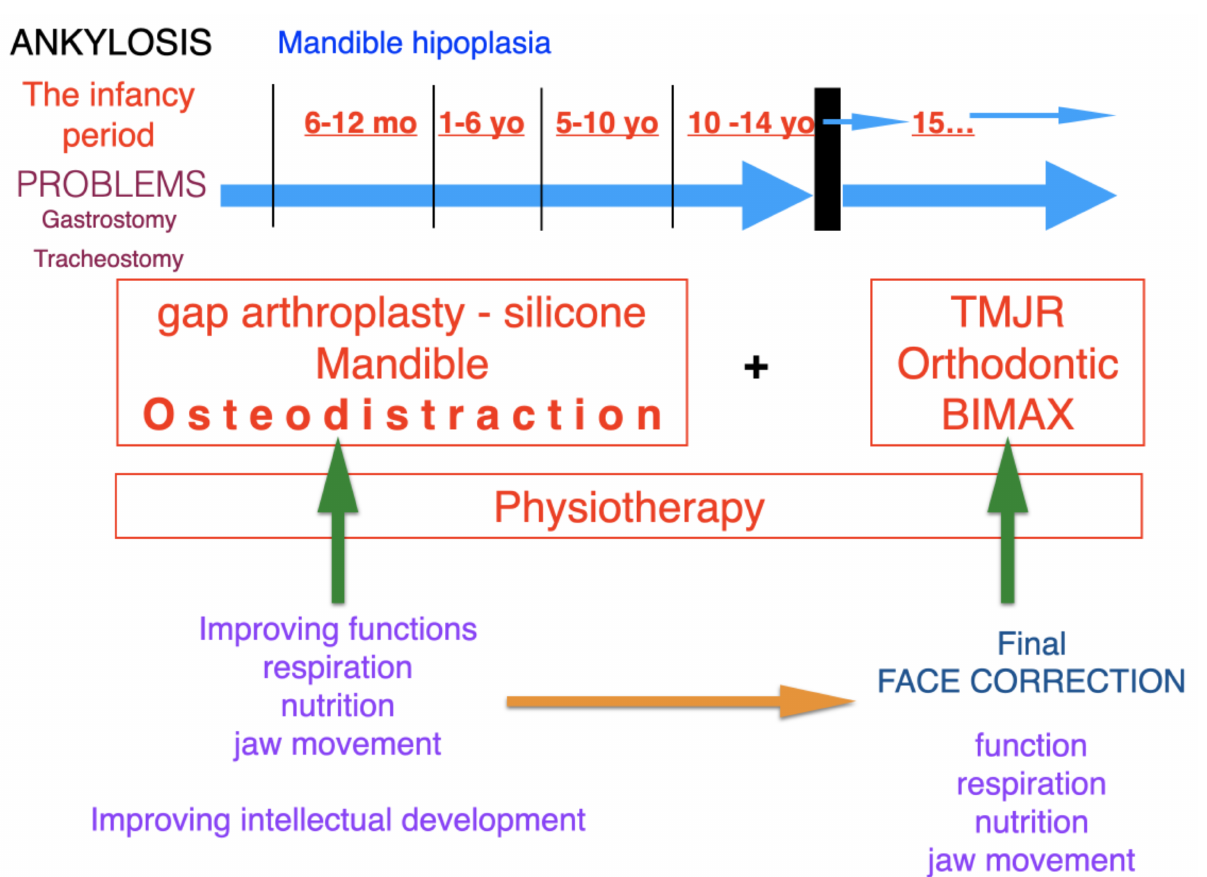
Figure 1. Protocol for the treatment of ankylosis from early childhood to the final resolution of the facial reconstruction problem. Ankylosis, characterised by major craniofacial hypoplasia, causes a number of respiratory pathologies and food intake disorders in the infancy period. These problems may be surgically resolved at an early stage of development through such procedures as tracheostomy or gastrostomy. The surgical treatment consists in restoring the function and assuring the natural pa- tency of the respiratory tract and alimentary tract in paediatric patients. Mandibular osteodistraction is performed in order to open the upper respiratory tract; the next stage involves complete removal of the ankylotic block to restore mandibular movement. The whole surgical treatment is integrated with physiotherapeutic procedures. The restoration of normal function improves the patient’s intellectual and psychophysical development. We apply the final facial reconstruction treatment when the patient reaches full skeletal maturity. The treatment involves orthognathic surgery and orthodontic therapy, along with the placement of the alloplastic TMJ